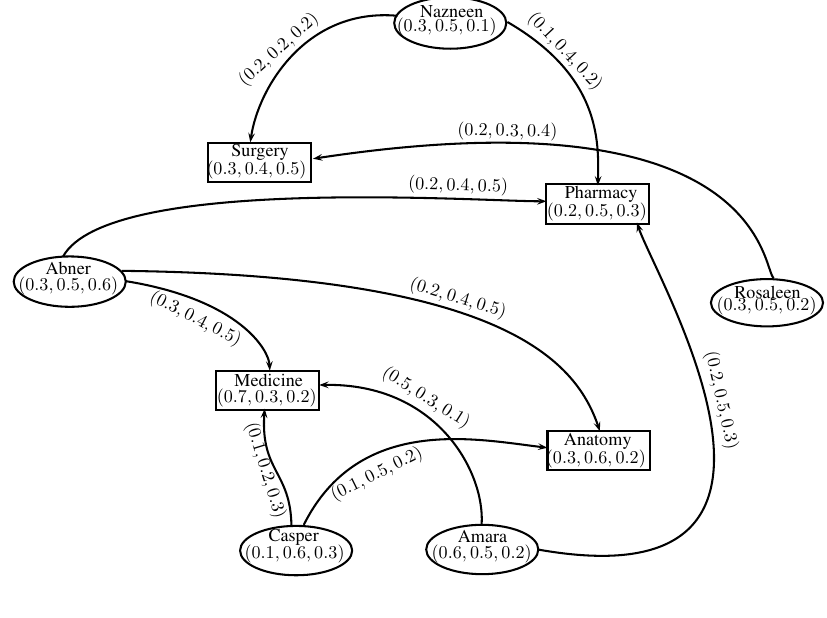
Figure 19. IN-digraph.